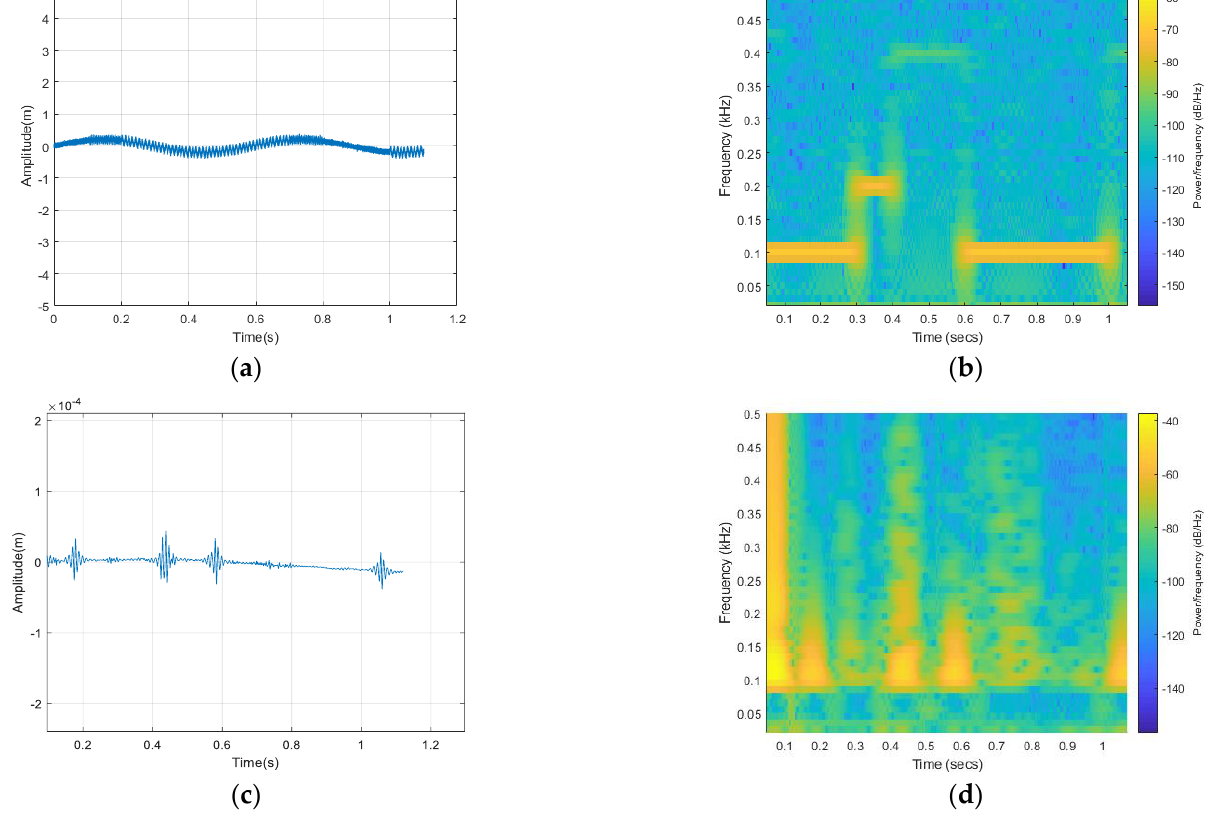
Figure 6. ( a ) The proposed algorithm’s result (weak wind); ( b ) time−frequency result; ( c ) filtering method’s result (weak wind); ( d ) time−frequency result.